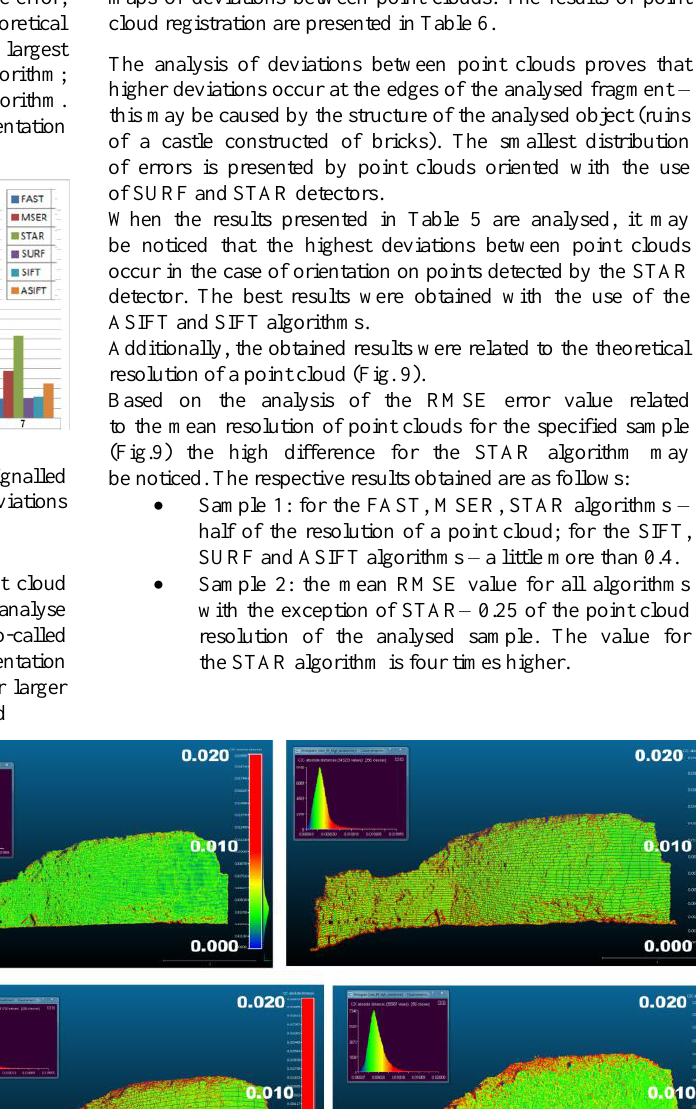
Figure. 8 Deviations between point clouds oriented with the use of point detectors: A) FAST, B) MSER, C) SIFT, D) SURF, E) ASIFT and F) CenSurE (STAR).